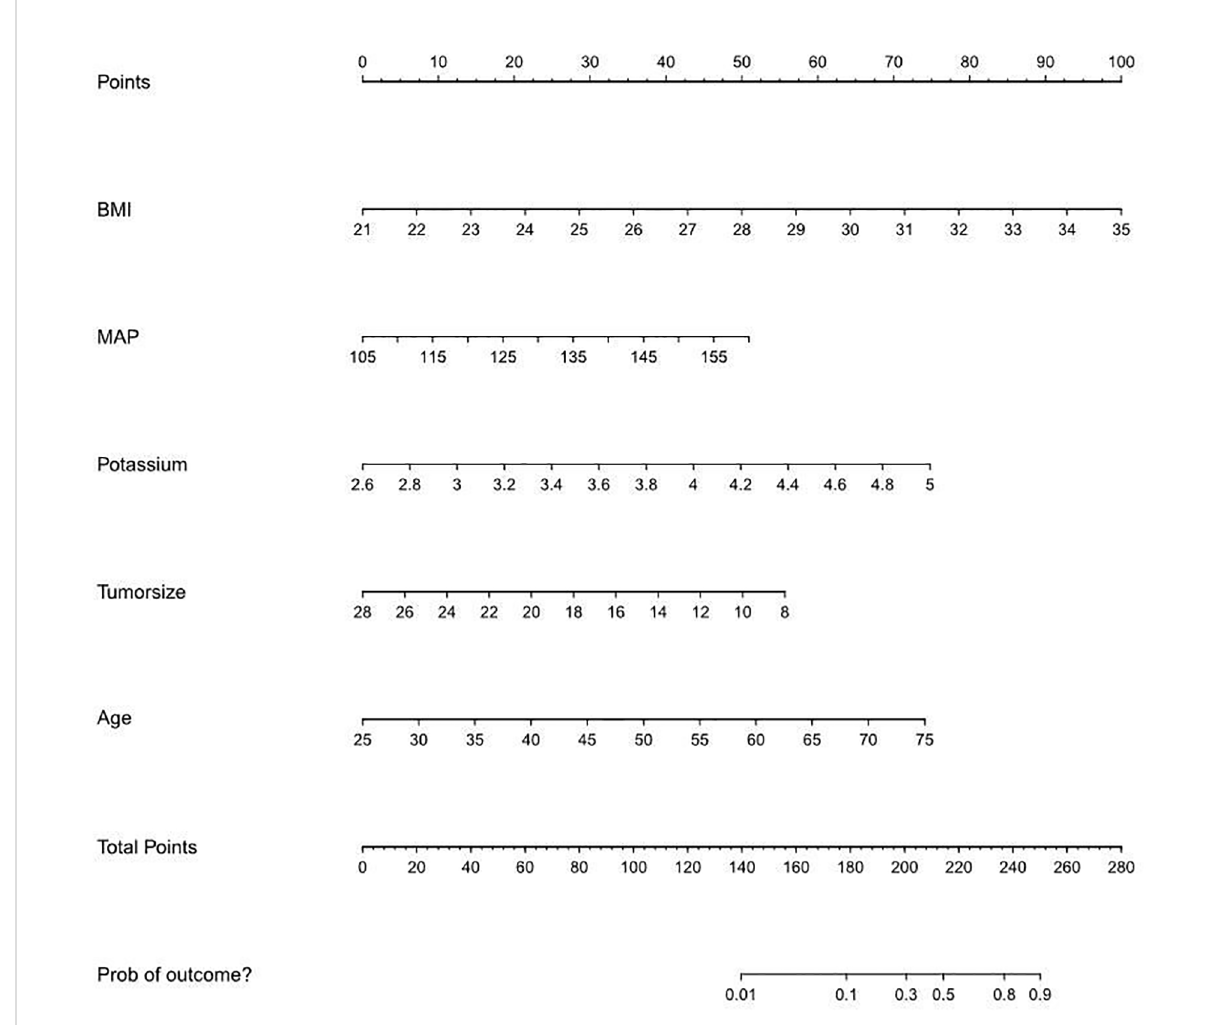
FIGURE 2 A nomogram predicting the risk of incomplete biochemical